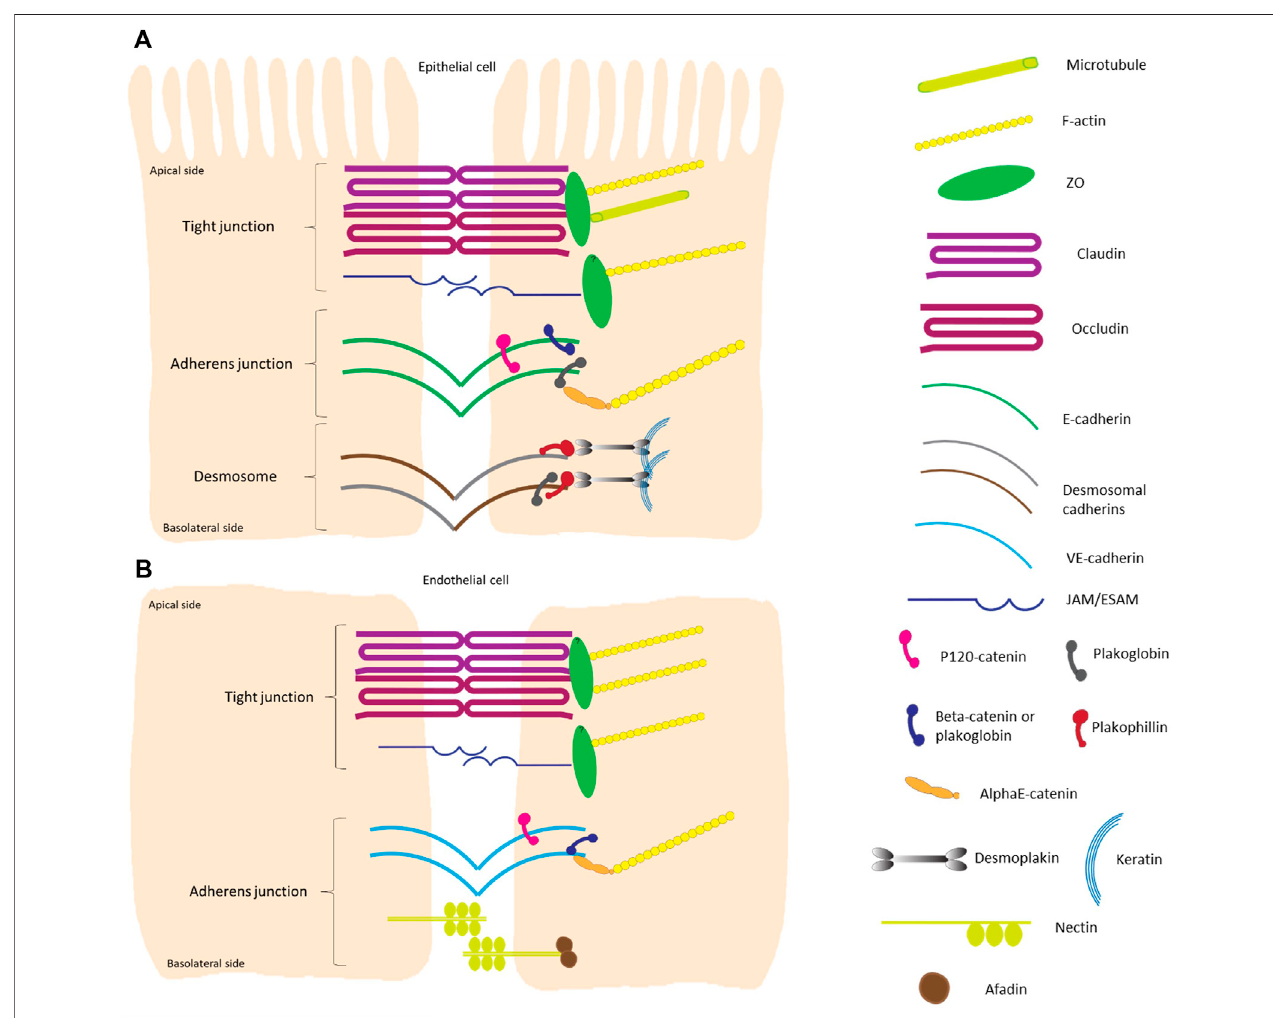
FIGURE 2 | Schematic overview of the different components of intercellular junctions in epithelial and endothelial cells. (A) Highly polarized epithelial cell- cellcontactsarecomposed oftightjunctions,adherensjunctionsand desmosomesfrom theapicaltobasalside.Thetransmembraneproteinsoftightjunctions are claudins, which largely determine the paracellular ion permeability between cells, and proteins like occludin and junctional adhesion molecules (JAMs) (Zihni et al., 2016; Otani and Furuse, 2020). The cytosolic plaque of the tight junctions is a complex protein network, with adaptor proteins containing multiple protein-protein interaction motifs that are connected to F-actin and microtubules. One of the main cytoplasmic tight junction proteins are of the zonula occludens (ZO) family. Adherens junctions consist of transmembrane cadherin proteins, such as E-cadherin, and cytoplasmic proteins that are members of the catenin family; p120-catenin binds to E-cadherin closest to the intercellular space while α -catenins anchor the cadherin-catenin complex to the actin cytoskeleton by binding to the armadillo proteins β -catenin and/or plakoglobin (Gumbiner 2005; Perez-Moreno and Fuchs, 2006; Meng and Takeichi, 2009). The main transmembrane proteins in the desmosomal complex are two types of cadherins: desmogleins and desmocollins. They form heterodimers that make up the fundamental adhesive unit of desmosomes (Harrison et al., 2011). The cytoplasmic side of the desmosomal cadherins are linked with plakophilin and plakoglobin, which in their turn bind both todesmoplakin to makeup theconnection totheintermediate fi lament (keratin) complex of thecell(Green and Gaudry, 2000; Garrod and Chidgey, 2008). (B) Tight junctions in fl at endothelial cells are very similar to those in polarized epithelial cells. The major difference is that there is no microtubule to bind to in the endothelial cells. Adherens junctions consist of vascular endothelial cadherin (vascular-endothelial) in endothelial cells and do not contain plakoglobin as cytoplasmic protein. Transmembrane nectin protein attached to the cytoplasmic afadin can be found in endothelial cells (Wallez and Huber, 2008). The overall height of a polarized cell grown in vitro is ~15 μ m, fi gures are not on scale.